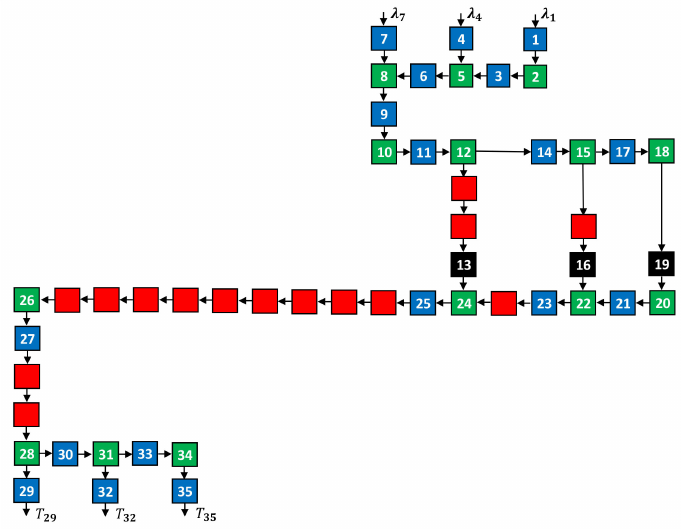
Figure 20. Production line topology after bu ff ers are allocated by API-VNS in the case of λ = 0.1 in experiment